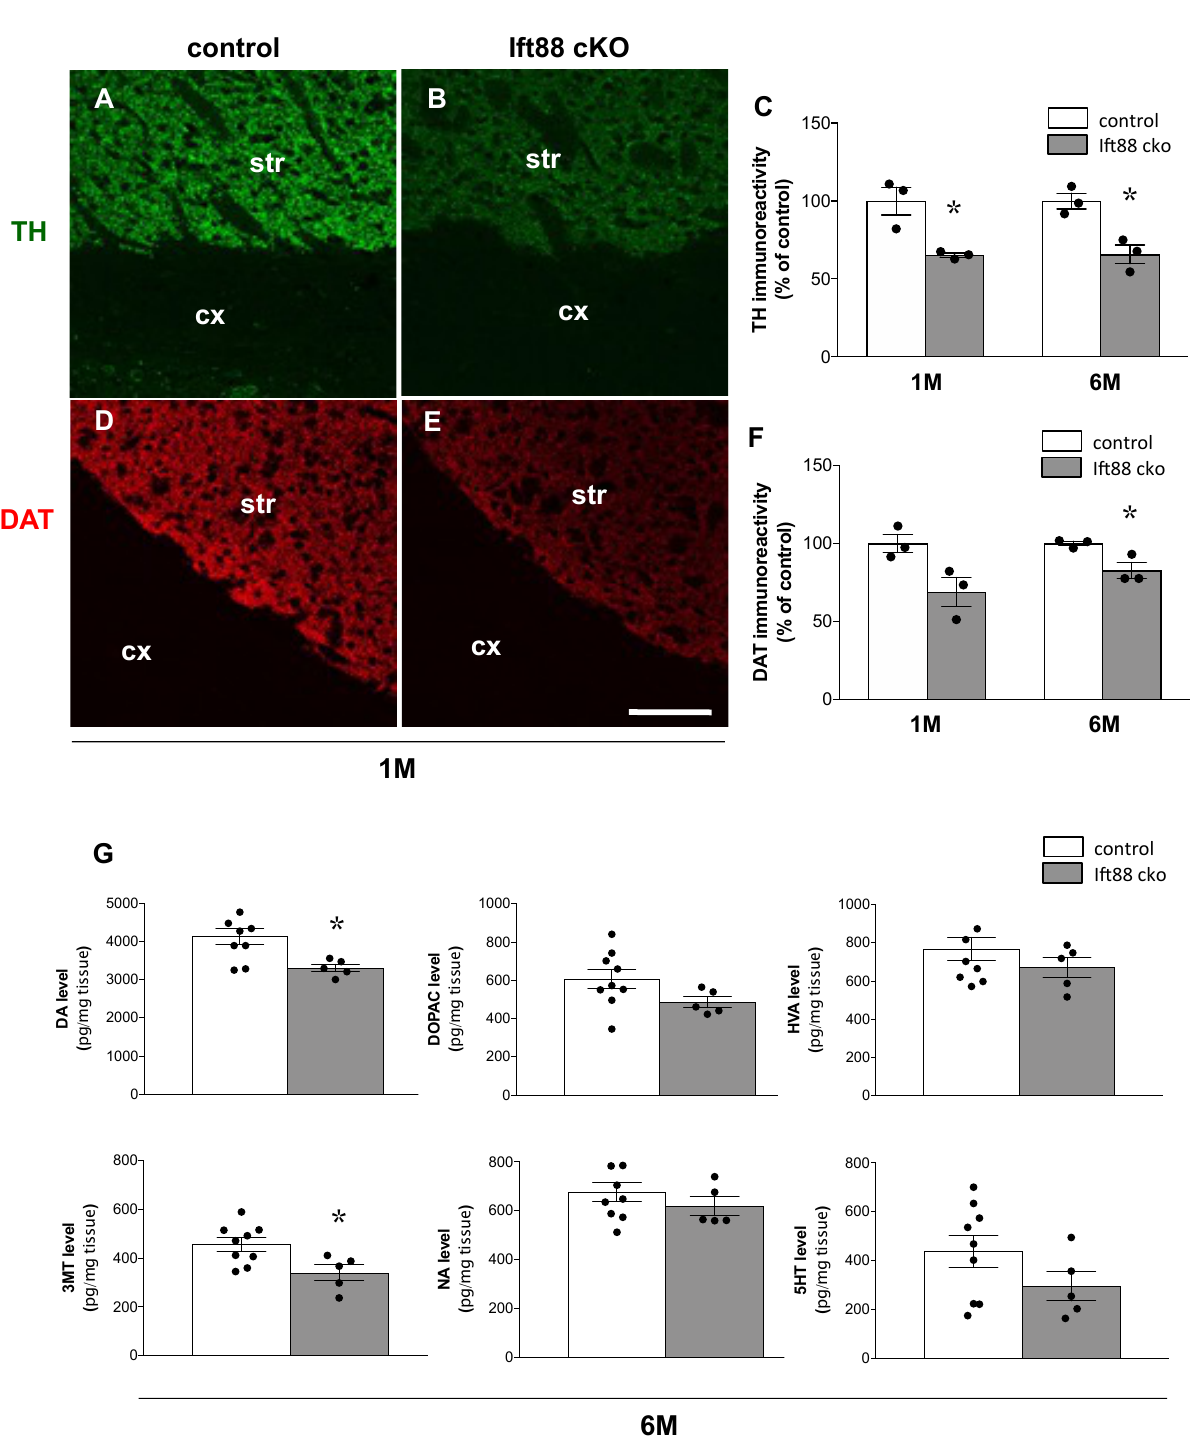
Figure 2. Loss of primary cilia in DA neurons results in decreased striatonigral integrity. ( A , B ). Representative confocal Figure 2 images of coronal striatal sections showing TH immunoreactivity (green) and ( D , E ) DAT immunoreactivity (red) in control and Ift88 cKO mice at 1 month. ( C , F ) Analysis of TH and DAT fluorescence mean intensities in control and Ift88 cKO dorsal striatum at 1 and 6 months ( n = 3 mice per group). ( G ) Quantification of dopamine (in figure abbreviated as DA for simplicity), its major metabolites (DOPAC, HVA, 3-MT), and other monoamines (NA, 5-HT) in the striatum of control and Ift88 cKO mice by HPLC-EC at 6 months ( n = 9 controls, n = 5 Ift88 cKO). The data are presented as the mean ± SEM. Statistical significance between the indicated groups determined by unpaired two-tailed Student’s t -test, * p < 0.05 (for details, see also supplementary statistical information). Abbreviations: str, striatum; cx, cortex. Scale bar, 100 µ